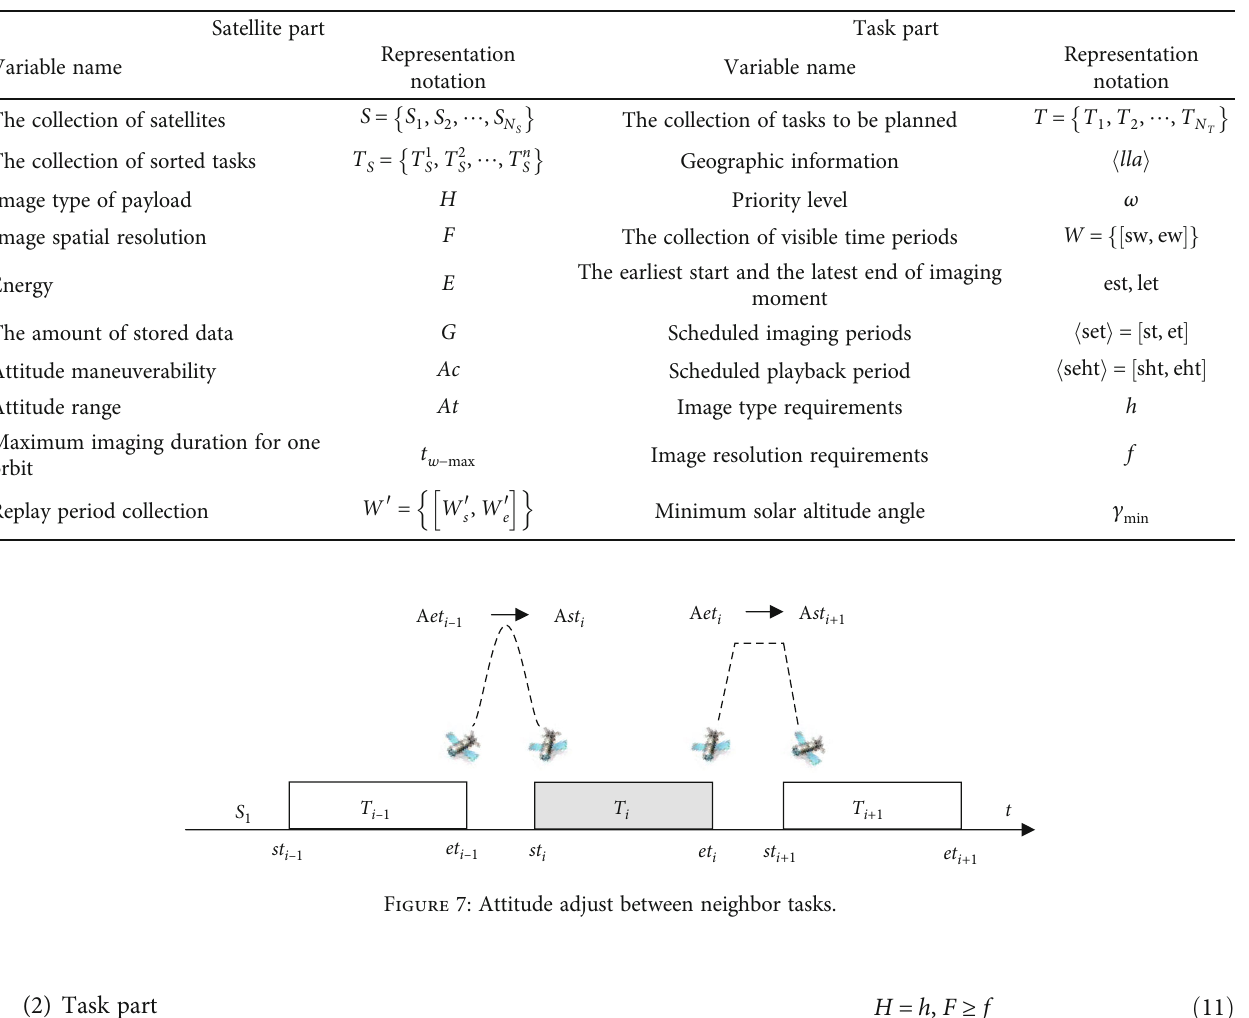
Table 1: Variable names and representation notations.